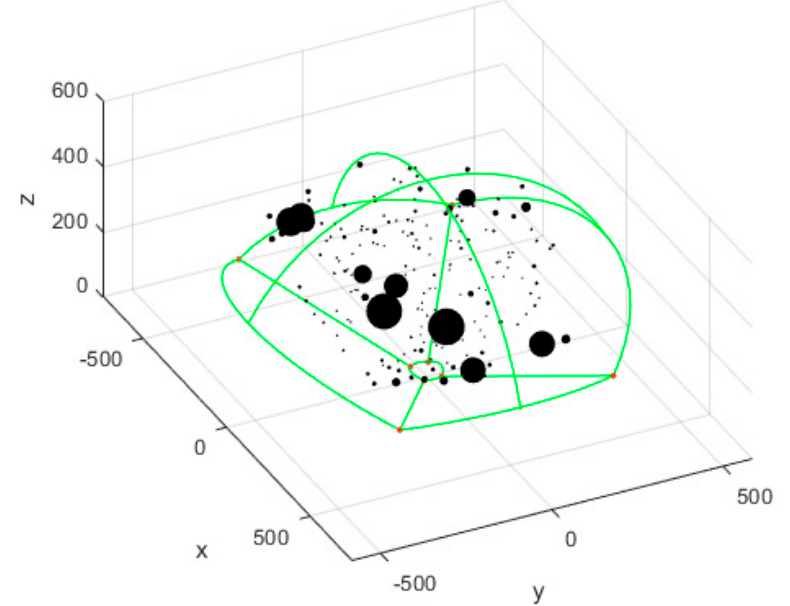
Figure 9. Up to 60 cm: overall view. X , y , and z axis are in mm.